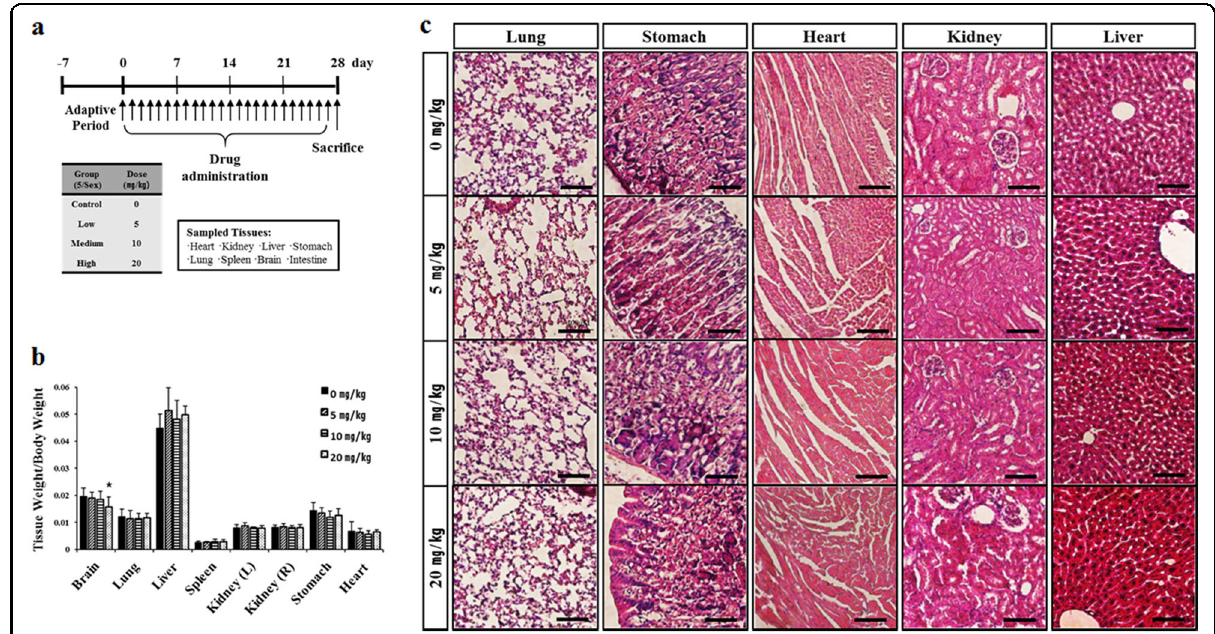
Fig. 4 Repeated-dose toxicity study. a Schedule for repeated-dose toxicity test of TAT-TVTSP. b The organs were weighed, and the values were expressed as the organ weight/body weight and presented as the means ± SD of 10 mice per group. Differences were assessed by one-way ANOVA. * P < 0.05 compared with the brain weight of the untreated control. c Fixed organ samples were dehydrated, paraf fi nized, and embedded. Sections of 4 µm were stained with H&E and observed under a microscope. Scale bar, 100